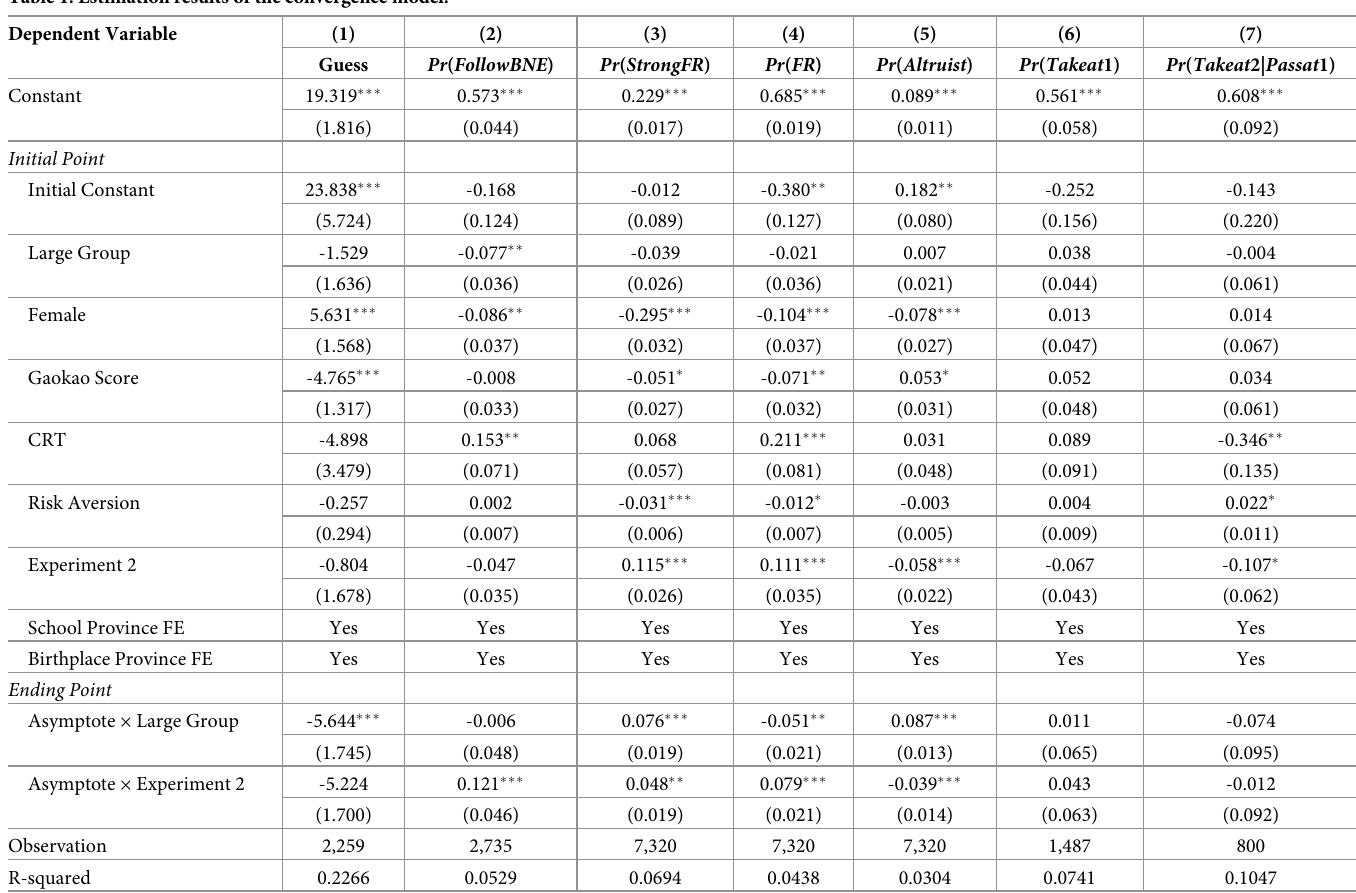
Table 1. Estimation results of the convergence